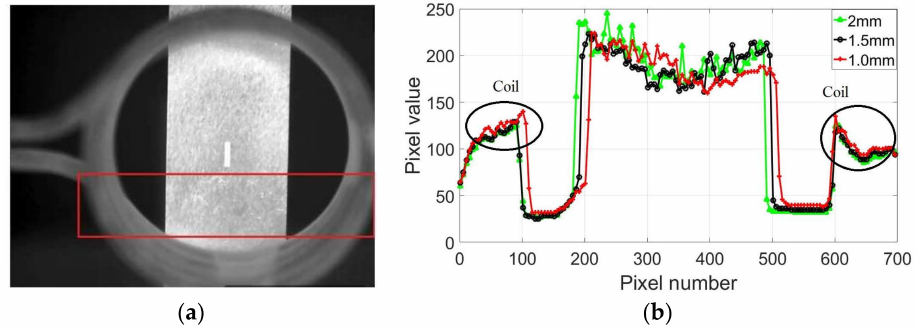
Figure 15. Data analysis of image: ( a ) non-crack area and ( b ) temperature distribution of line of three samples with different widths.